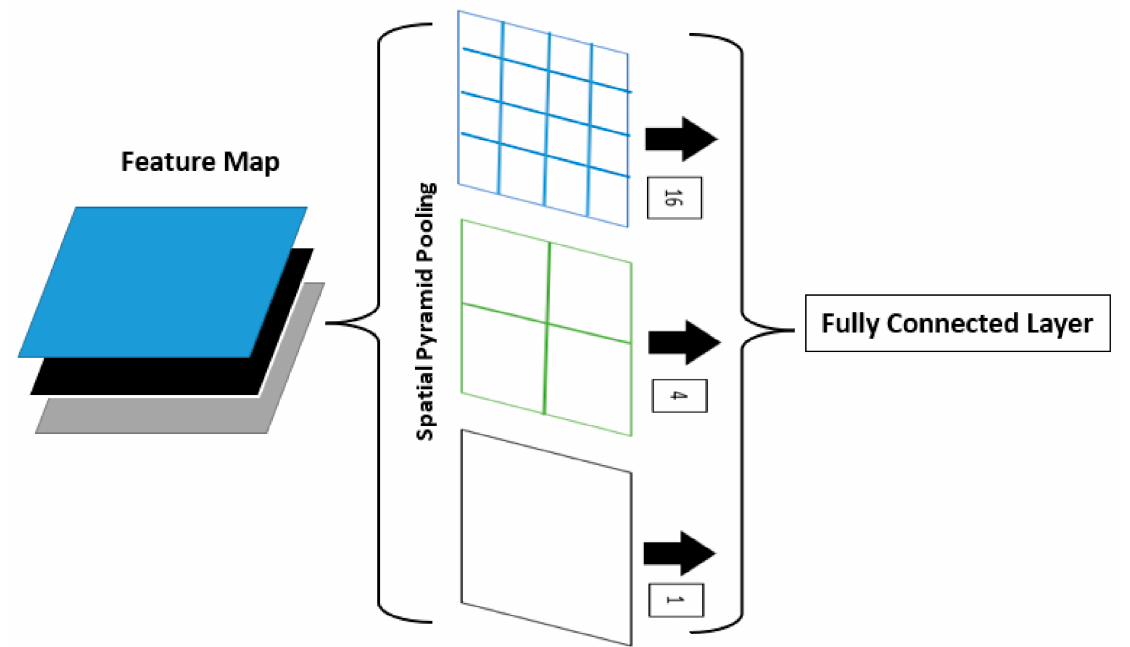
Figure 1. Spatial pyramid pooling (SPP)